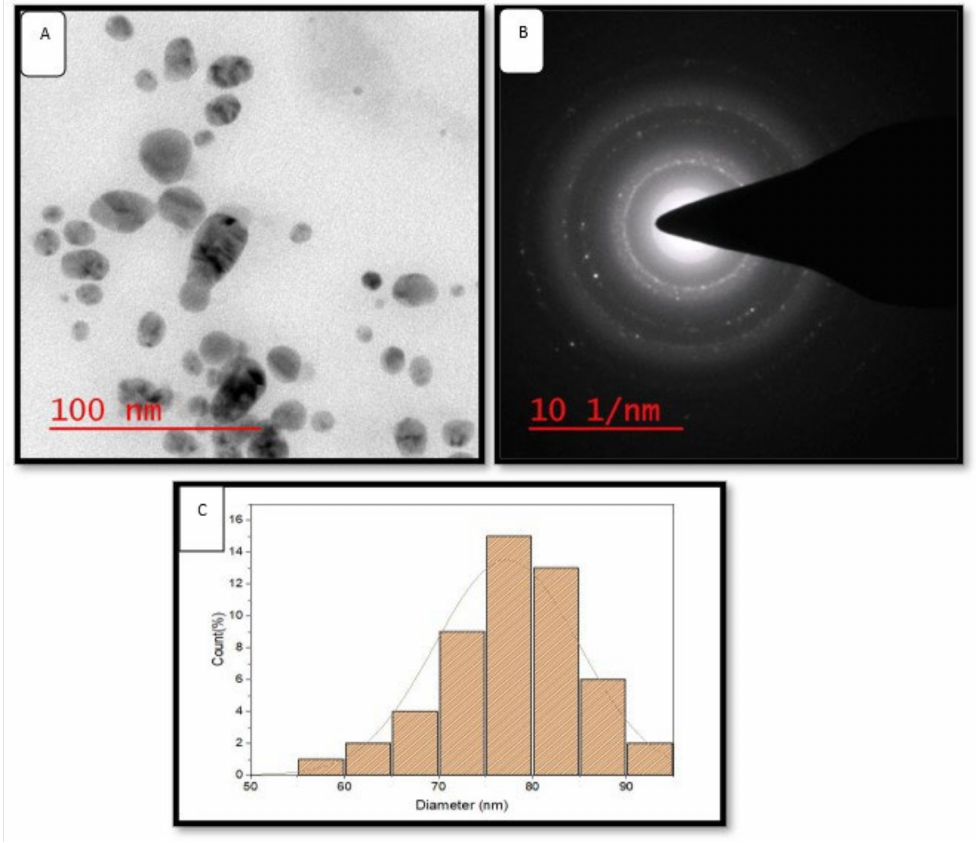
Figure 5. HR-TEM images of green AgNPs. ( A ) HR-TEM images of green AgNPs at 200 nm, ( B ) SEAD patterns of green AgNPs, ( C ) size distribution histogram of green